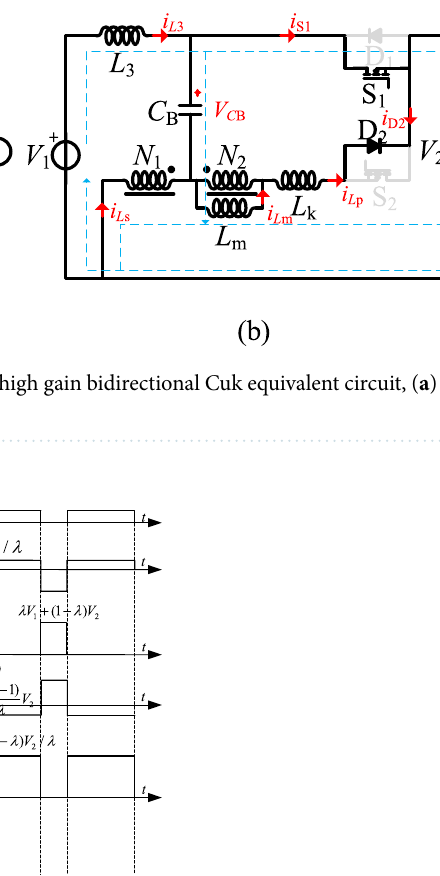
Figure 8. The main operation waveforms of the key components in the step-up mode.